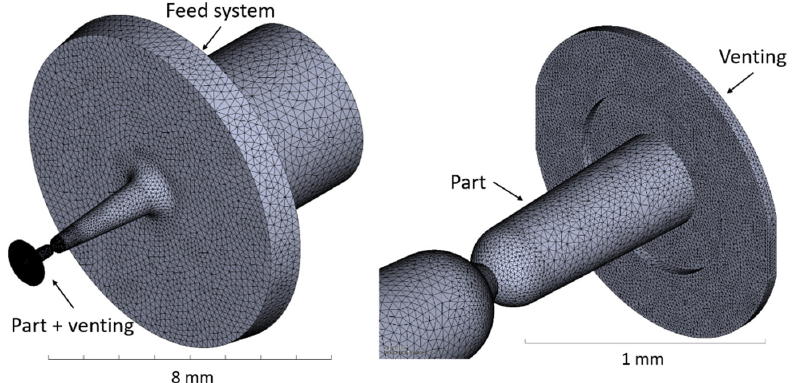
Figure 5. Multi-scale mesh and modified model geometry of Case 2 to include the flash formation in the simulation of the micro-cap [31].